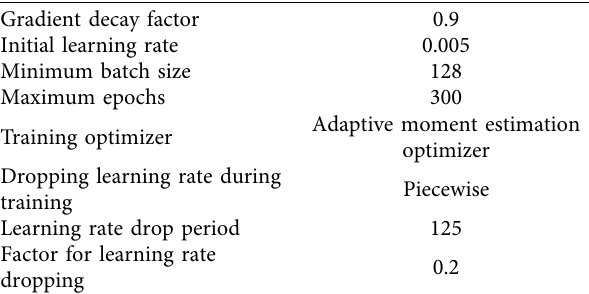
Table 1: Model hyperparameters for Uni-LSTM and BiLSTM. Gradient decay